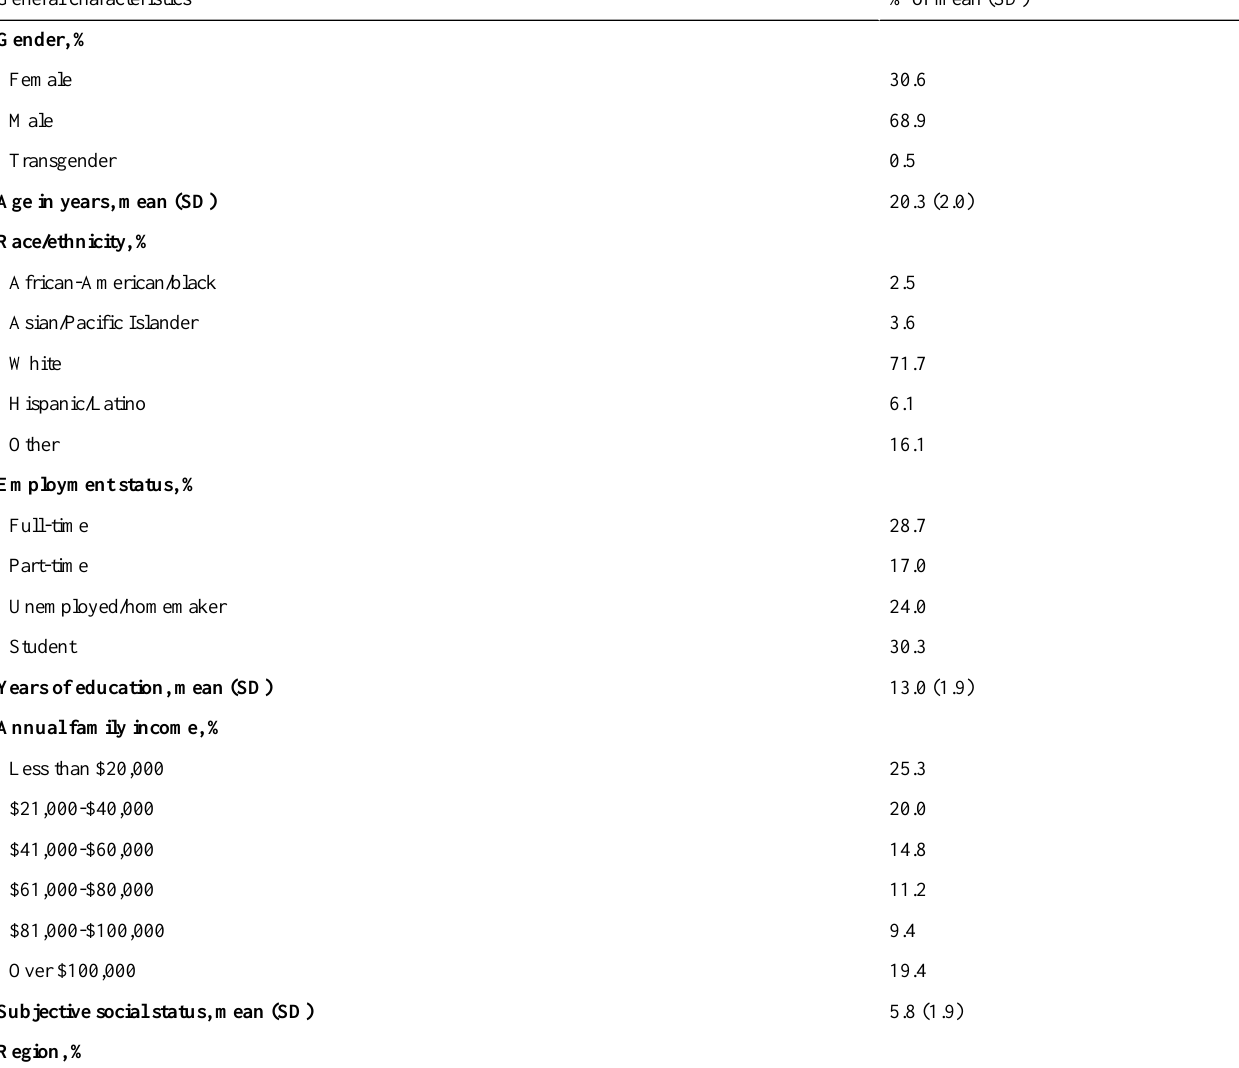
% or mean (SD)General